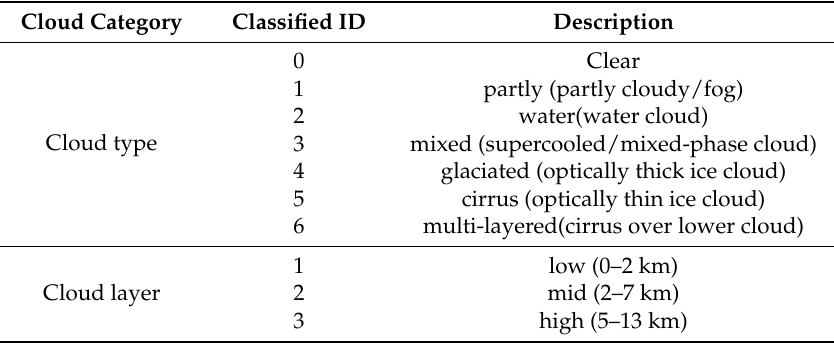
Table 1. GOES surface and insolation products cloud categories adapted from